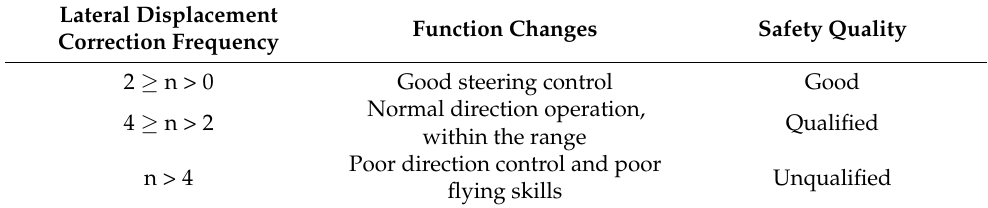
Table 9. Function changes in “F2: rudder”